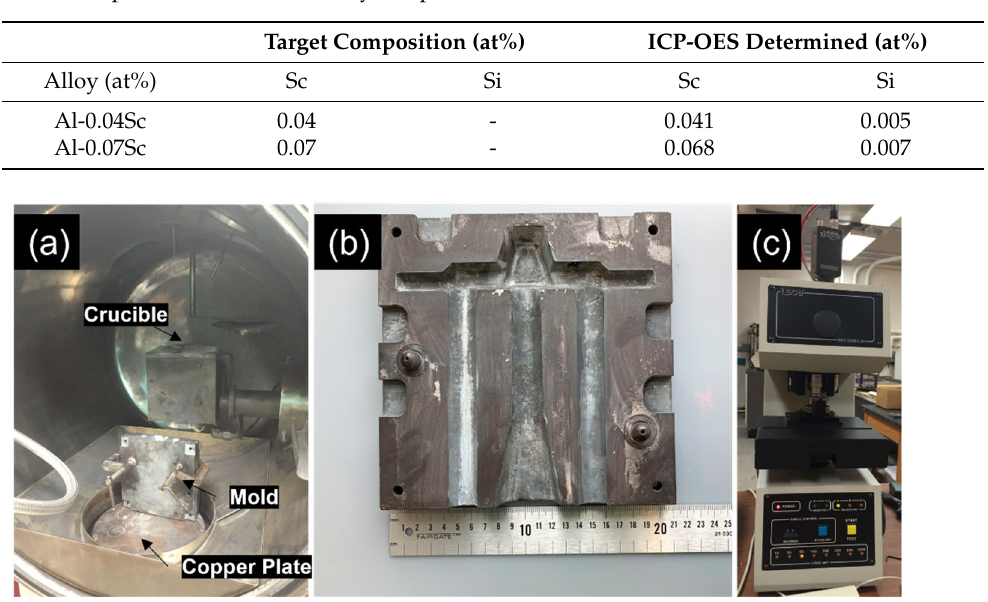
Table 1. Expected and observed alloy compositions.